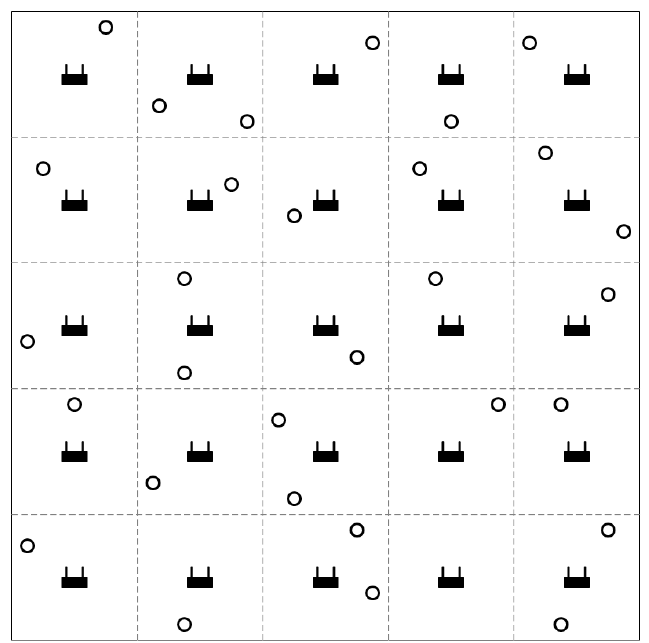
Figure 4. An example simulation environment. The APs are placed in a grid topology and the mobile nodes are randomly deployed in the